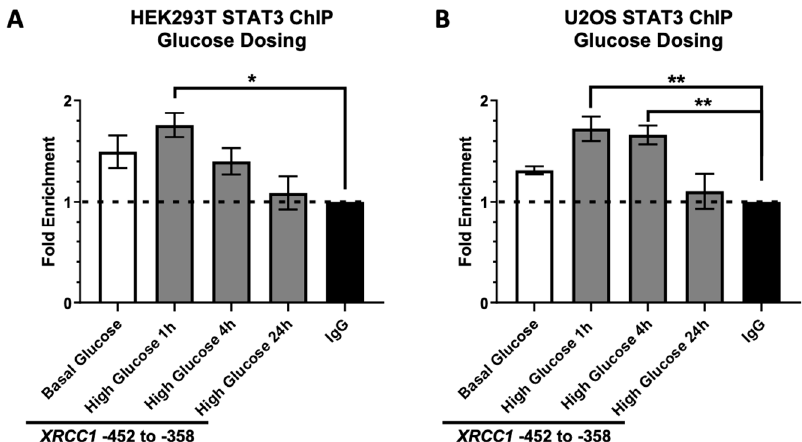
Figure 2. Increased STAT3 occupancy at the XRCC1 promoter following acute high glucose exposure. ChIP analysis of STAT3 occupancy at the XRCC1 promoter following acute high glucose (30 mM). exposure for 1, 4, and 24 h in HEK293T ( A ) and U2OS ( B ) cells normalized to respective IgG controls. * p < 0.05, ** p < 0.01.